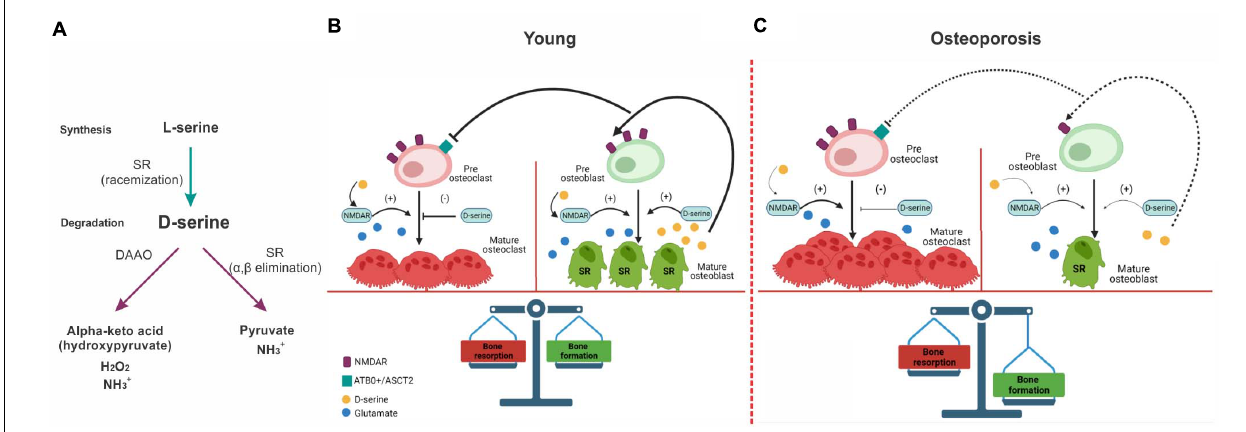
FIGURE 1 | Effect of NMDAR and D-serine in bone-resorption and bone-formation processes in young animals and during osteoporosis. (A) Mechanisms of biosynthesis and degradation of D-serine. D-serine is synthetized from L-serine by SR. D-serine is catabolized by DAAO producing the corresponding alpha-keto acid (hydroxypyruvate), hydrogen peroxide and ammonia. D-serine can also be degradated through α , β elimination, obtaining pyruvate, and ammonia as products. (B) In young healthy subjects, osteoclast and osteoblast maturation is facilitated by NMDAR activity. D-serine synthetized by SR in mature osteoblast (bold lines) would supress osteoclast maturation through amino acid transportes (ARB0 + and ASCT2) located in pre-osteoclasts and would promote osteoblast and osteoclast maturation through the activation of NMDAR. (C) During the osteoporosis-associated with aging, there is a decrease in the expression of NMDAR in pre-osteoblast that would affect their maturation. This would lead to a decrease in D-serine released by osteoblast (dashed lines) and a reduction of the positive input onto the osteoblast maturation. In parallel, a reduction of D-serine would decrease the inhibition of osteoclast maturation favoring bone resorption. SR, Serine racemase; DAAO, D-amino acid